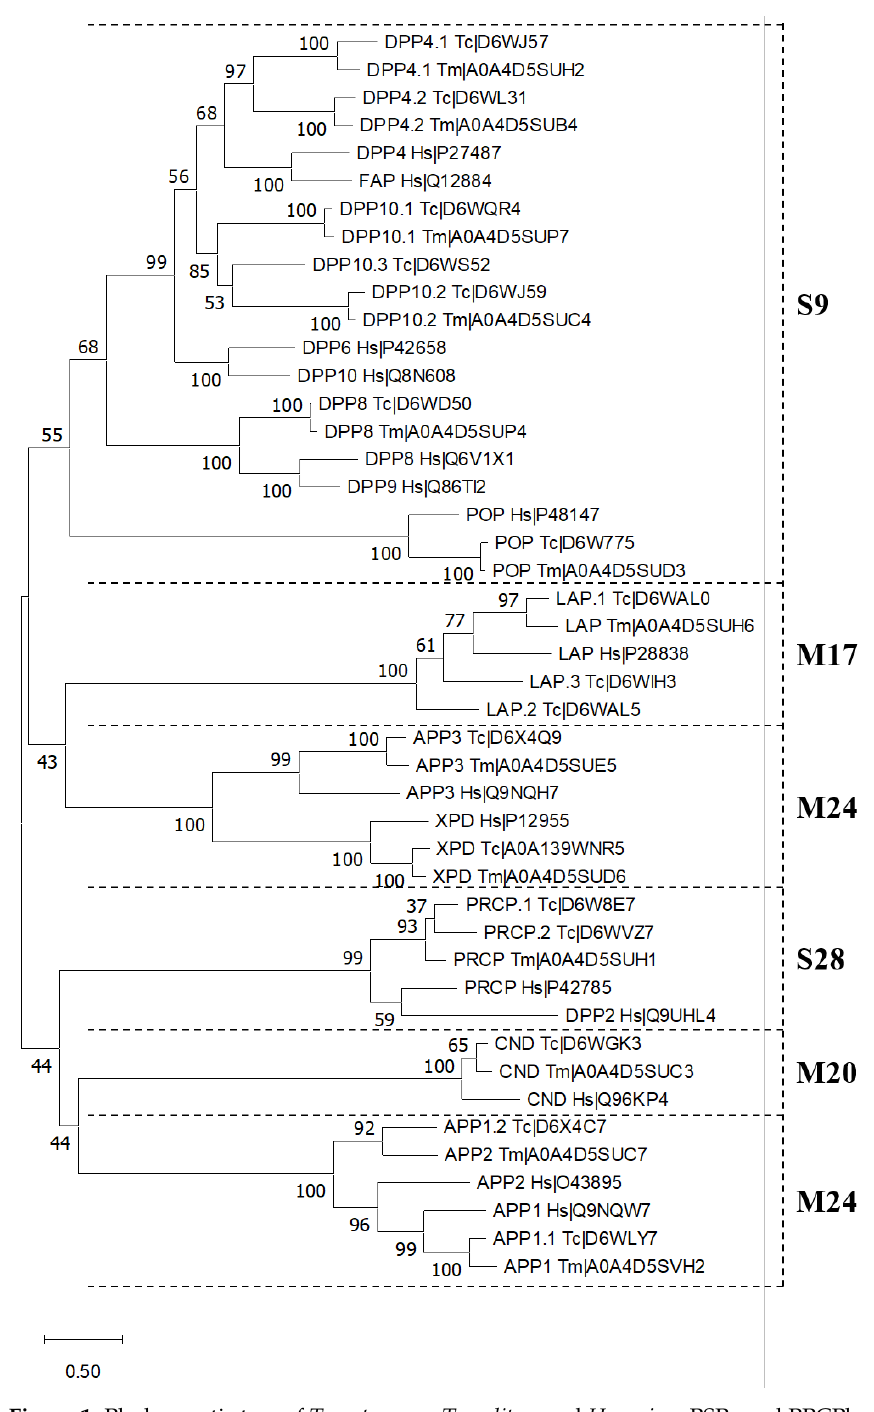
Figure 1. Phylogenetic tree of T. castaneum , T. molitor , and H. sapiens PSPs and PPCPbs constructed using the maximum likelihood method.